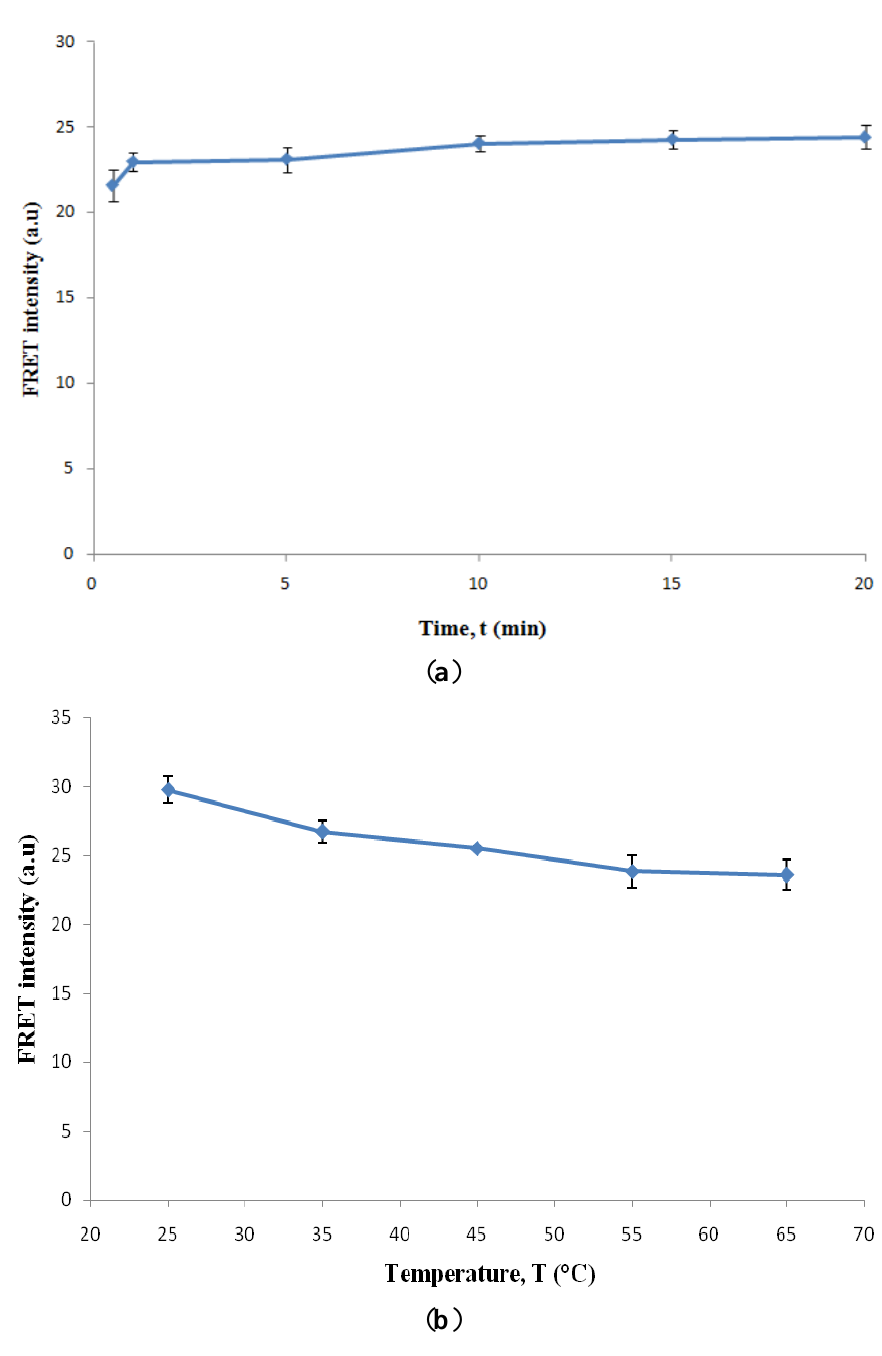
Figure A1. Factors affecting the hybridization signal intensity; effect of ( A ) hybridization time ( B ) hybridization temperature and ( C ) target DNA concentration on FRET